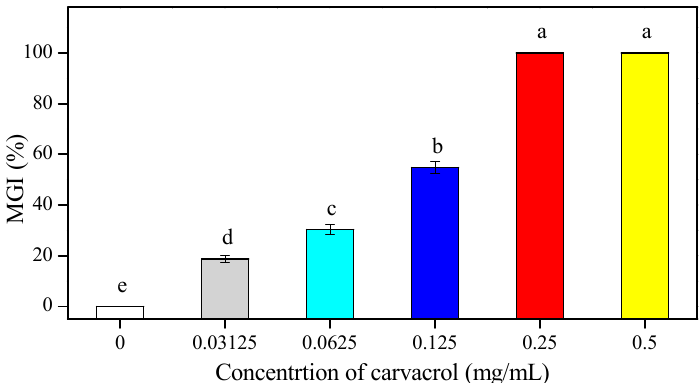
Figure 1. The antifungal efficacy of carvacrol on the in vivo mycelial growth inhibition (MGI) of P. digitatum on PDA. Bars indicate the mean ± standard deviation (S.D.) and those labeled with different letters ( a , b , c , d , and e ) were significantly different according to Duncan’s test ( p < 0.05).